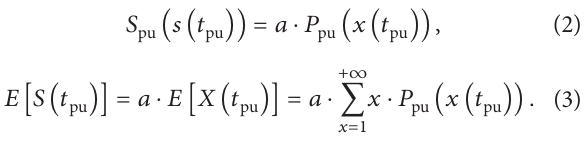
time line. Assume 𝑡 1 is the first time point when he publishes the data, Data 1 , after he comes online, and 𝑡 𝑘 is the last time point the user publishes the data, Data 𝑘 , before he goes offline . Now let us consider one of the friends at the time point 𝑡 𝑢 out in the user’s friend circle. Assume that the friend goes offline 𝑓 just before the user publishes Data 𝑘 󸀠 (and at time point 𝑡 out after the user publishes Data 𝑘 󸀠 −1 ) and then comes online at 𝑓 after the user goes offline. Therefore, Data 𝑘 󸀠 to time point 𝑡 in Data 𝑘 are the data that the friend missed when he is offline and consequently need to be updated when he comes online. Since the user is already offline, the friend can only update the missed data from other online friends where the data replicas are stored. Note that if the friend comes online before the user goes offline, the friend can update all missed data from the user directly. Therefore, data availability is not a problem under this